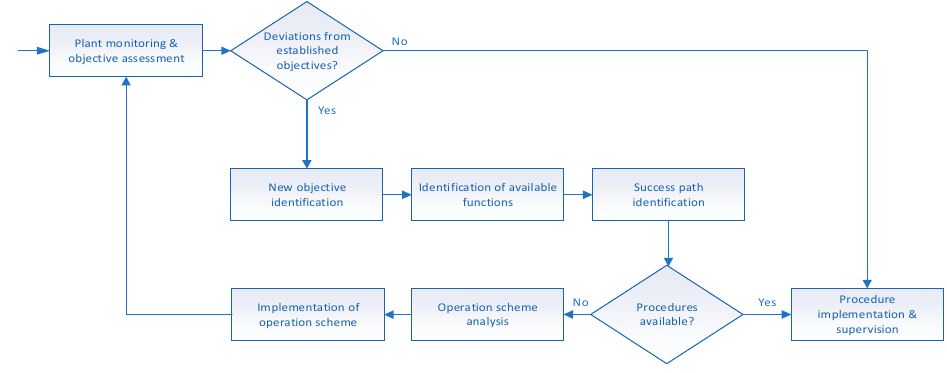
Figure 2. Functional block diagram of NoP-OST.